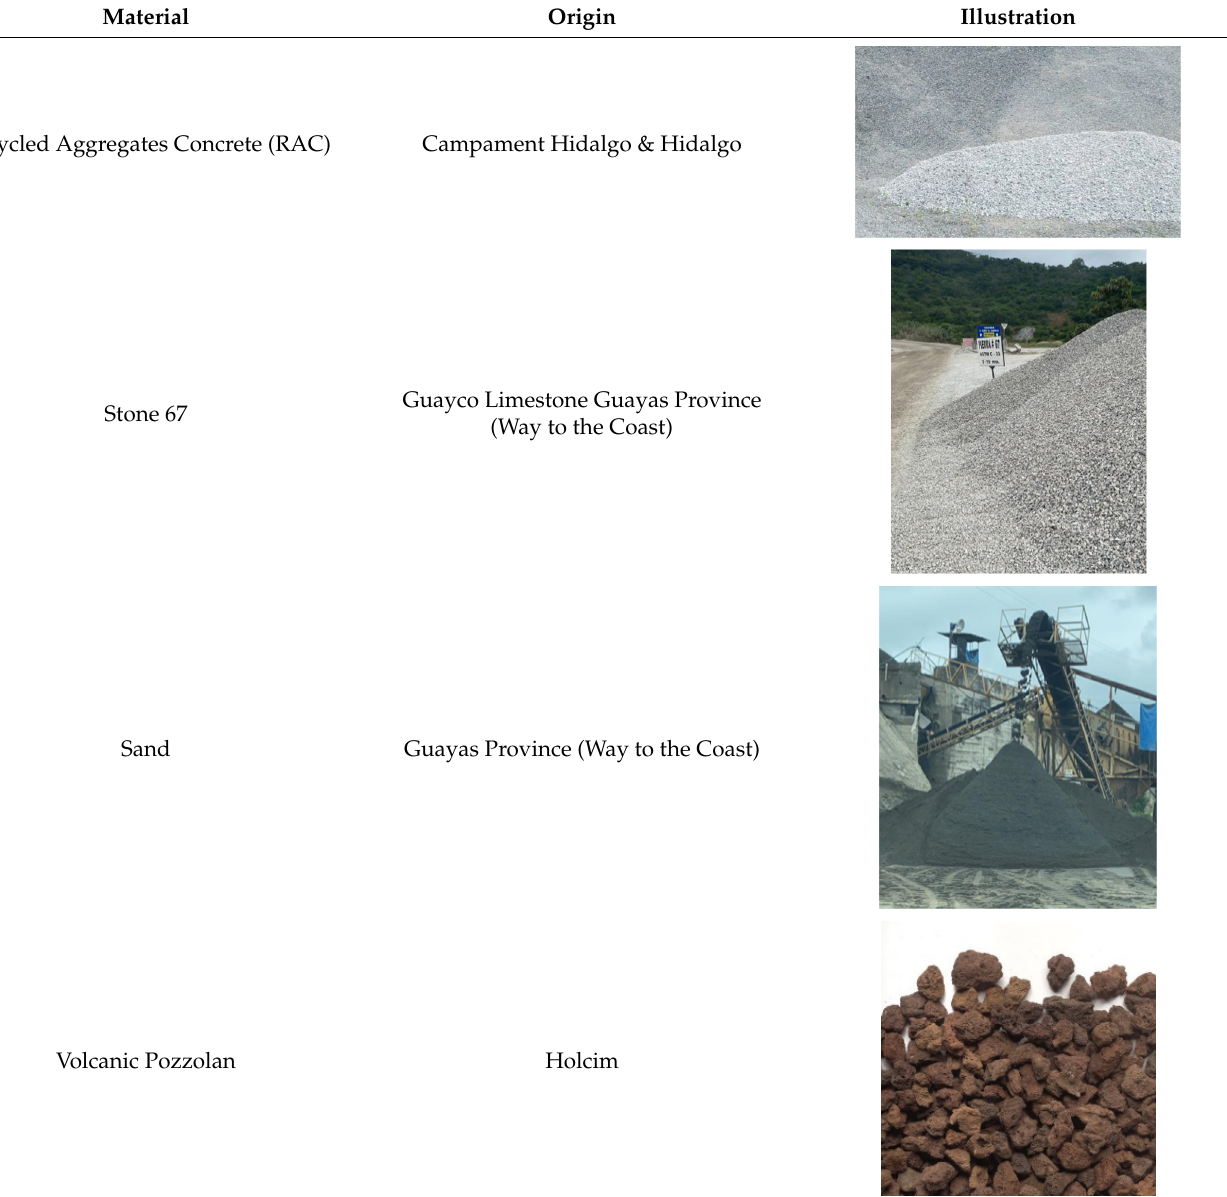
Table 3. Materials used in the experimental part.